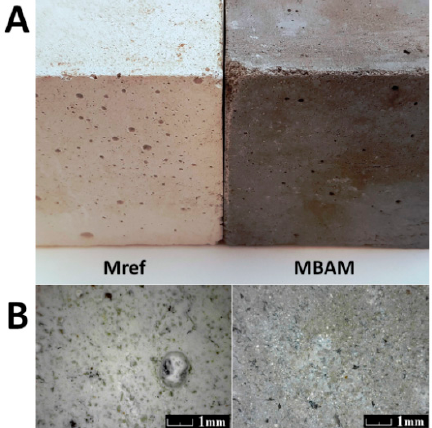
Figure 4. Particle size distribution—cumulative curves.